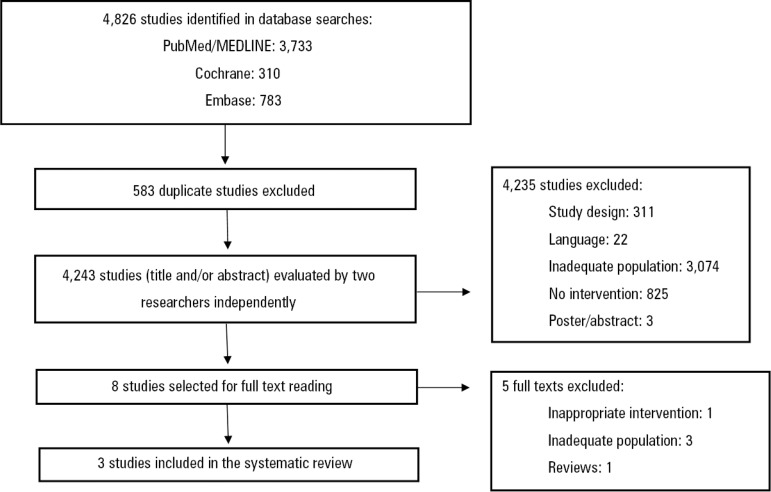
Flowchart of study selection.